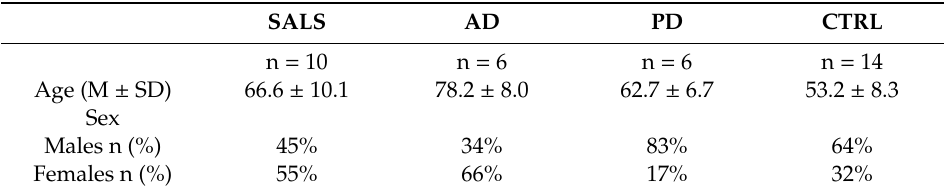
Table 3. Baseline characteristics of subjects recruited for this